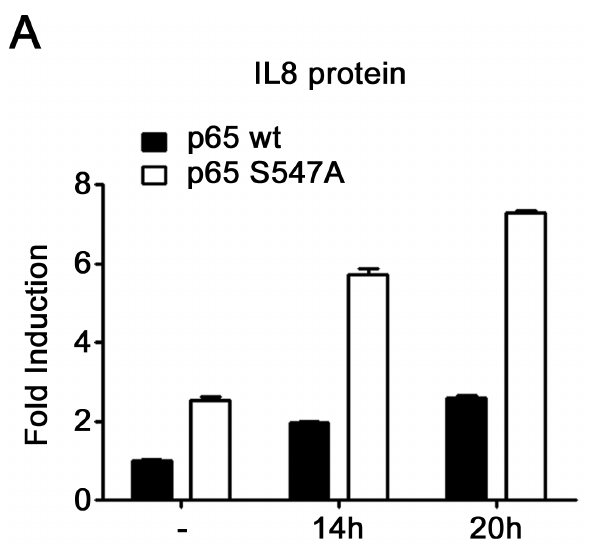
Figure 5. Higher IL8 protein level in cells expressing S547A mutated p65. ELISA analysis of IL8 protein level after the indicated times of etoposide treatment in HEK-293 cells expressing either p65 wt or p65 S547A